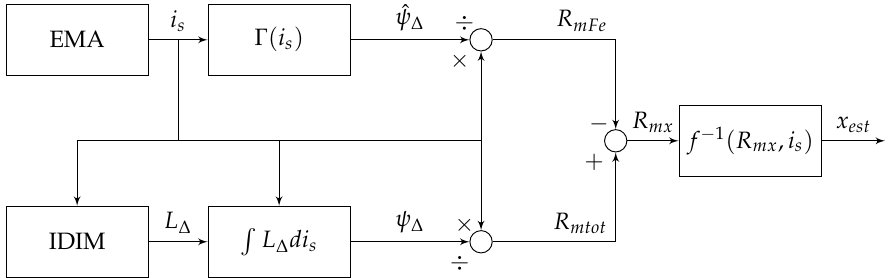
Figure 11. Schematic of the obtained self-sensing algorithm with hysteresis compensation. The current i s of the electromagnetic actuator (EMA) is measured. The IDIM technique estimates the actual incremental inductance, which is used for flux calculation. The difference between actual flux and model-based estimated flux depends on the air gap and is used for position estimation.